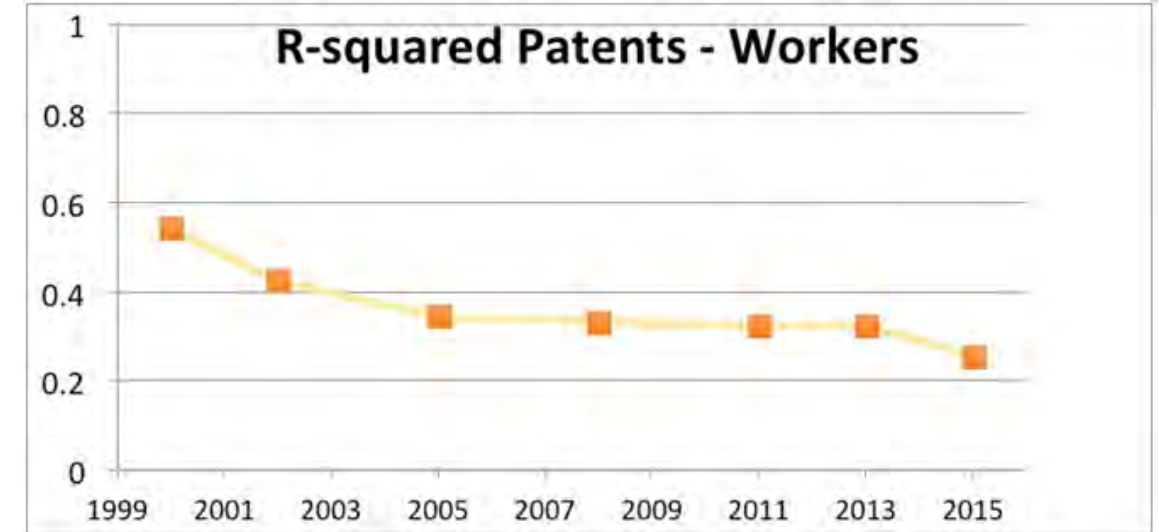
Figure 2. Coefficient of determination (R-squared) Patents-Workers for US metro areas from 2000-2015